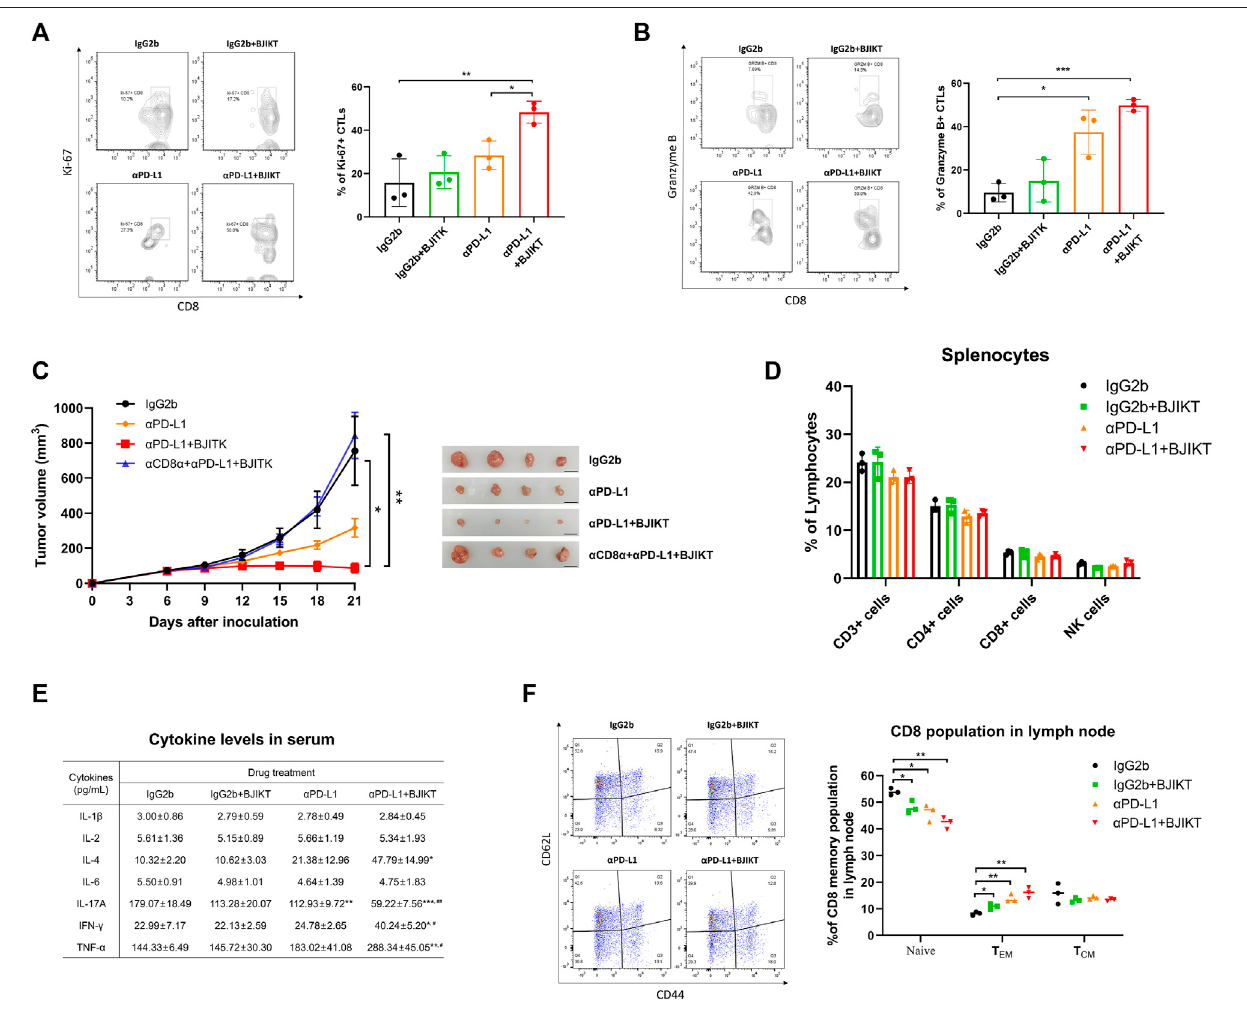
FIGURE 5 | BJIKT combined with anti-PD-L1 regulated the immune responses of CD8 + T-cells with anti-PD-L1 in MC38 tumor-bearing mice. (A,B) Flow cytometric analysis of CD8 + T-cells in tumor tissue after the treatment. Ki-67-expressing (A) and granzyme B-expressing (B) CD8 + T-cells. (C) Effect of CD8 depletion priortocombinationtreatment.Anti-CD8 α antibody (10 mg/kg) wasgivenintraperitoneally 1 daypriortoPD-L1antibodytreatment and threetimes aweek. (D) Effectof BJIKT on the systemic immune response in the splenocytes of MC38-bearing mice. (E) Change of in fl ammatory cytokines in serum collected from MC38-bearing mice. Cytokine levels (IL-1 β , IL-2, IL-4, IL-6, IL-17A, IFN- γ , and TNF- α ) were determined using Bio-Plex Pro Mouse Cytokine Assay kit. * p < 0.05, ** p < 0.01, and *** p < 0.001,compared totheIgG2bgroup; # p < 0.05and ## p < 0.01, compared tothe α PD-L1group. (F) ThefrequencyofmemoryCD8 + T-cellsinthetumor-draininglymph node. * p < 0.05 and ** p < 0.01, compared between each